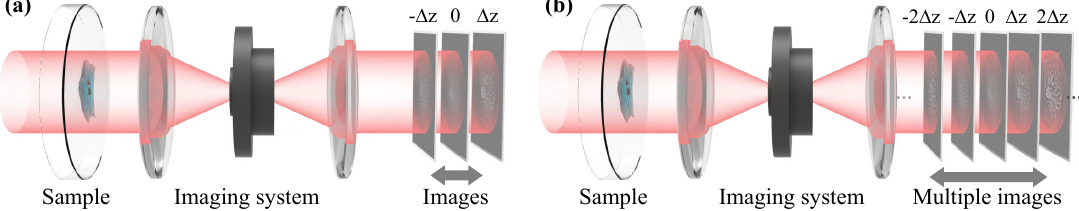
Figure 17. Typical experimential setup for TIE phase retrieval. ( a ) conventional three-plane TIE; ( b ) multi-plane TIE. The through-focus intensity stack can be acquired by moving either the object or the image